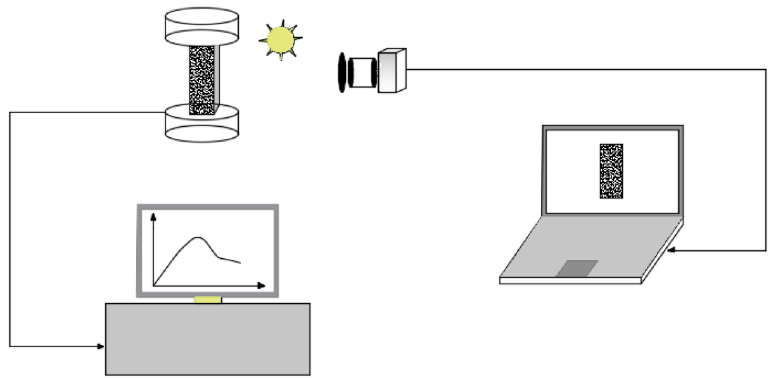
Figure 4. Uniaxial-DIC image of the testing system.